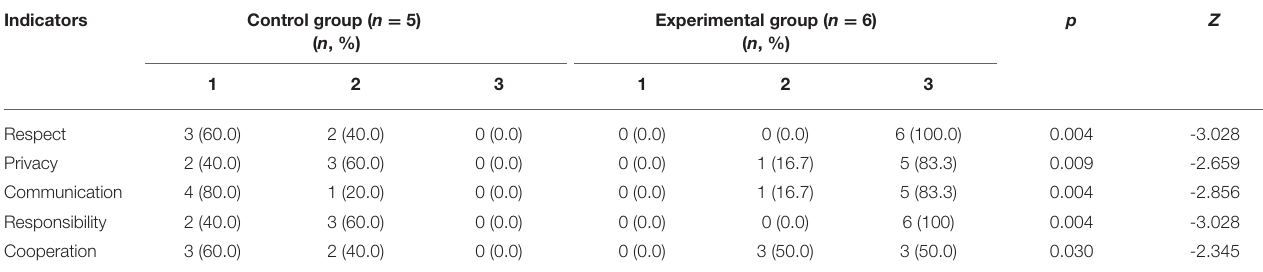
TABLE 2 | Residents’ professionalism assessment in the experimental and control groups. Indicators